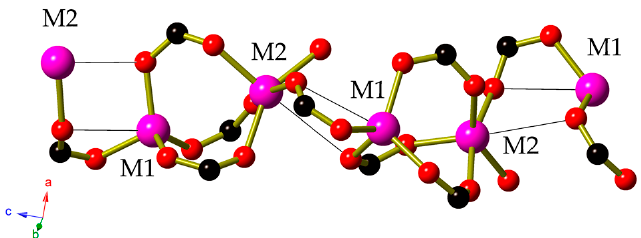
Figure 1. The coordination environment of the metal centres in Co 2 (BzOip) 2 (H 2 O). Long interactions between Co centres and carboxylate oxygen atoms are shown as thin black lines.